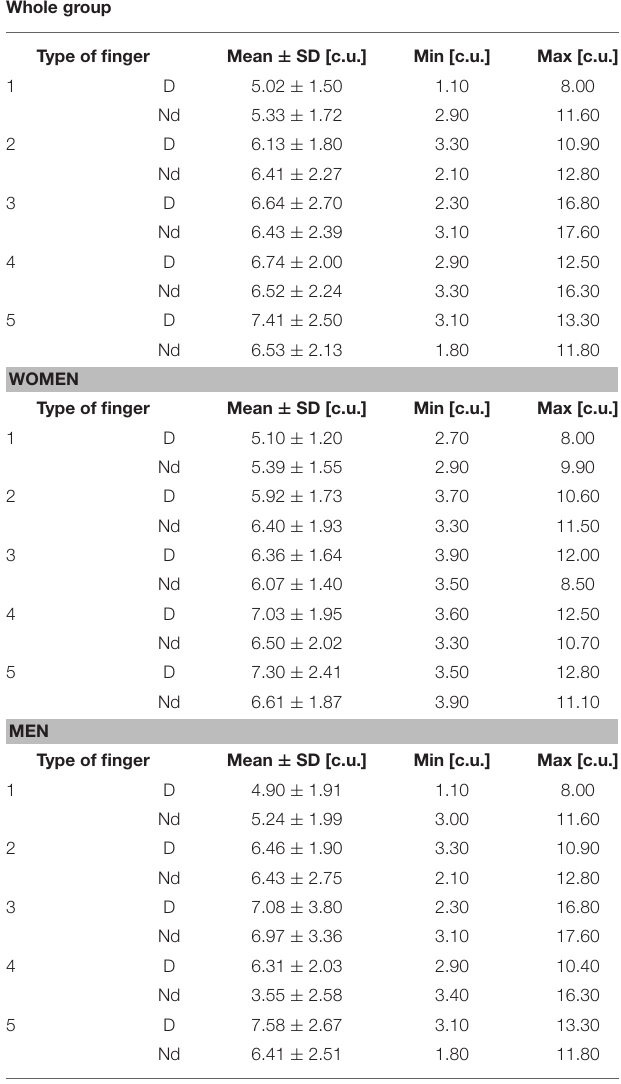
TABLE 5 | Values of r and p for correlations between the type of a finger and the TOWL value. Dominant hand